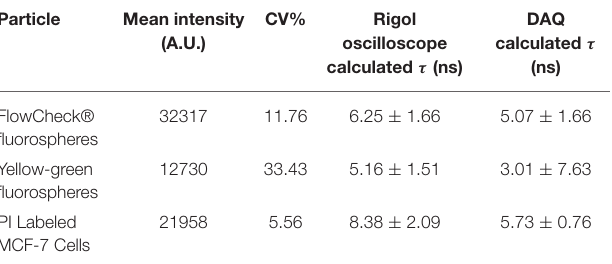
TABLE 1 | Mean fluorescence intensity values, oscilloscope and DAQ calculated fluorescence lifetime values for FlowCheck fluorospheres, yellow-green fluorospheres and PI-labled MCF-7